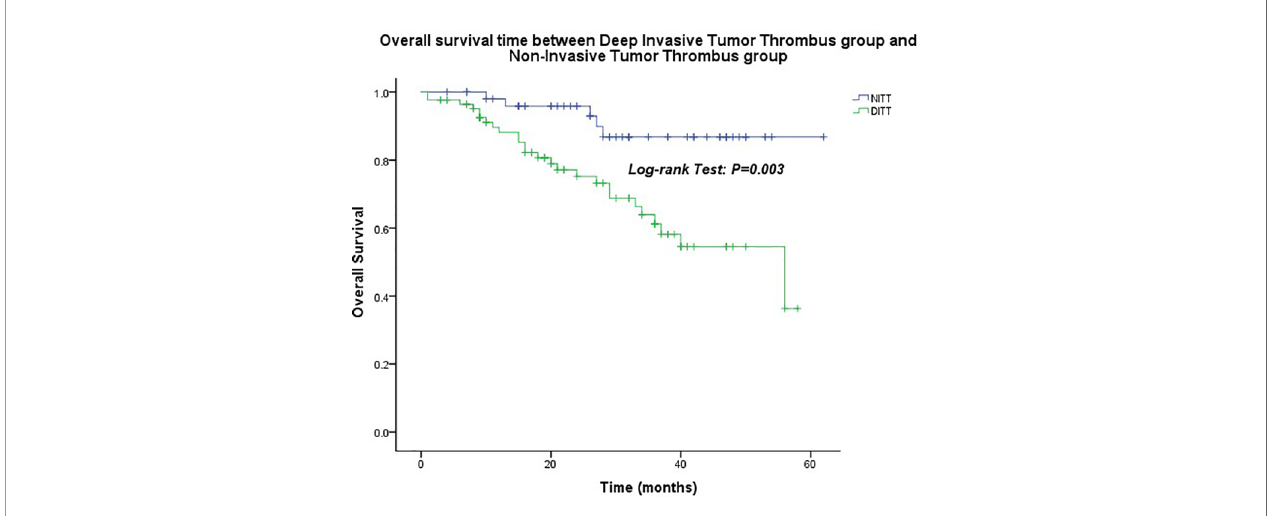
FIGURE 2 | Overall survival time between the Deep Invasive Tumor Thrombus (DITT) group and the Non-Invasive Tumor Thrombus (NITT)